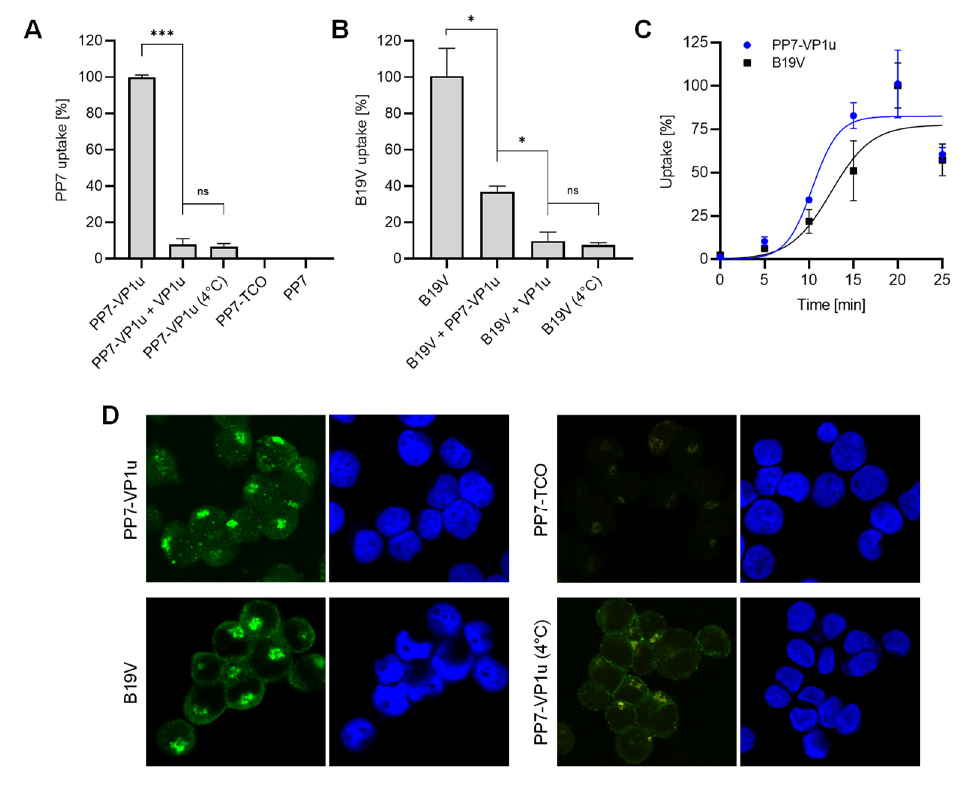
Figure 2. PP7-VP1u uptake into UT7/Epo cells. ( A ) PP7-VP1u uptake was quantified by RT-qPCR. For the competition, recombinant VP1u (500 ng) was added to the cells at 4 °C 40 min before incubation with PP7-VP1u. ( B ) Internalization of native B19V into UT7/Epo cells was quantified by PCR. For the competition, PP7-VP1u (10x molecular excess) or recombinant VP1u (500 ng) was added to the cells at 4 °C for 40 min before infection with B19V. The sample at 4 °C served as a negative control (no internalization). ( C ) Internalization kinetics determined by RT-qPCR (PP7-VP1u) or qPCR (B19V) at 5 min intervals. ( D ) Binding and uptake of Atto488-labeled PP7-VP1u constructs and native B19V. B19V was detected with human MAb 860-55D against capsids and stained with secondary Alexa-Fluor 488 anti-human antibody. PP7-TCO served as a negative control. The quantitative RT-PCR results are presented as the mean ± SD of three independent experiments. *** p < 0.001; * p < 0.05; ns, not significant.